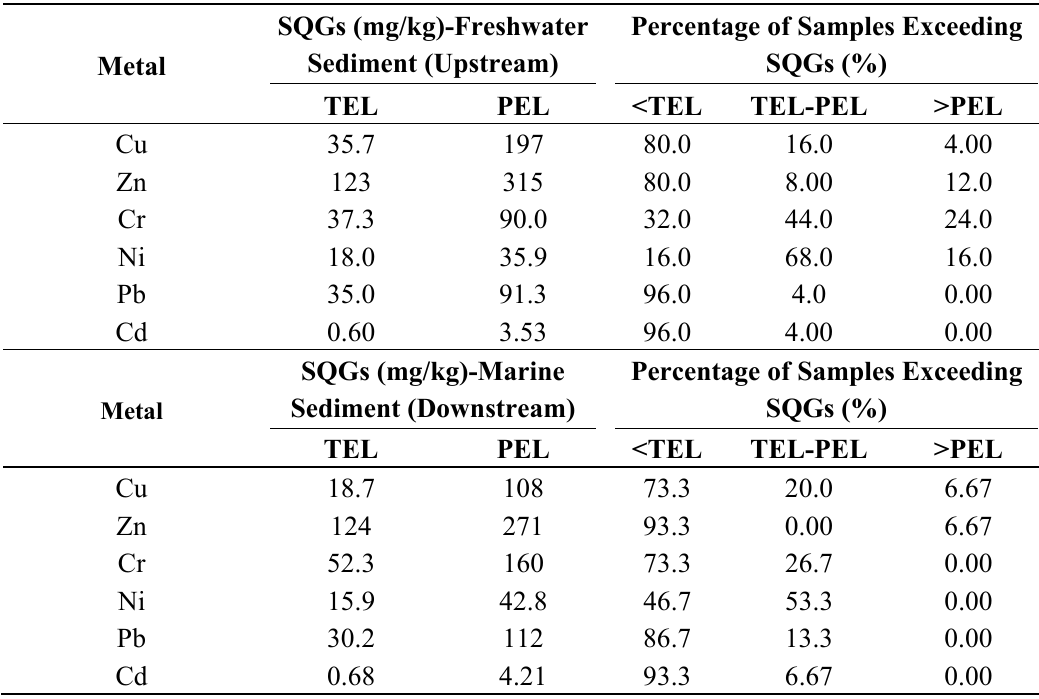
Table 2. Classification of sediment samples based on the proposed sediment